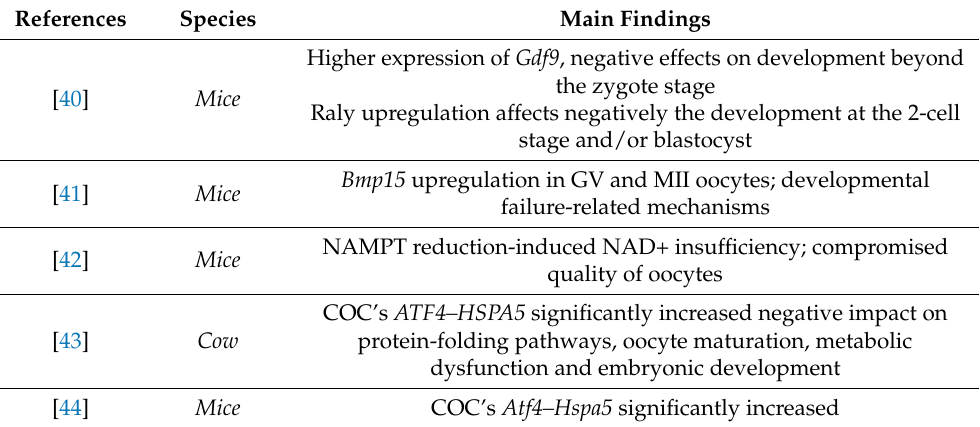
Table 4. Summary of the main findings related to the impact of a high-fat diet on gene expression related to